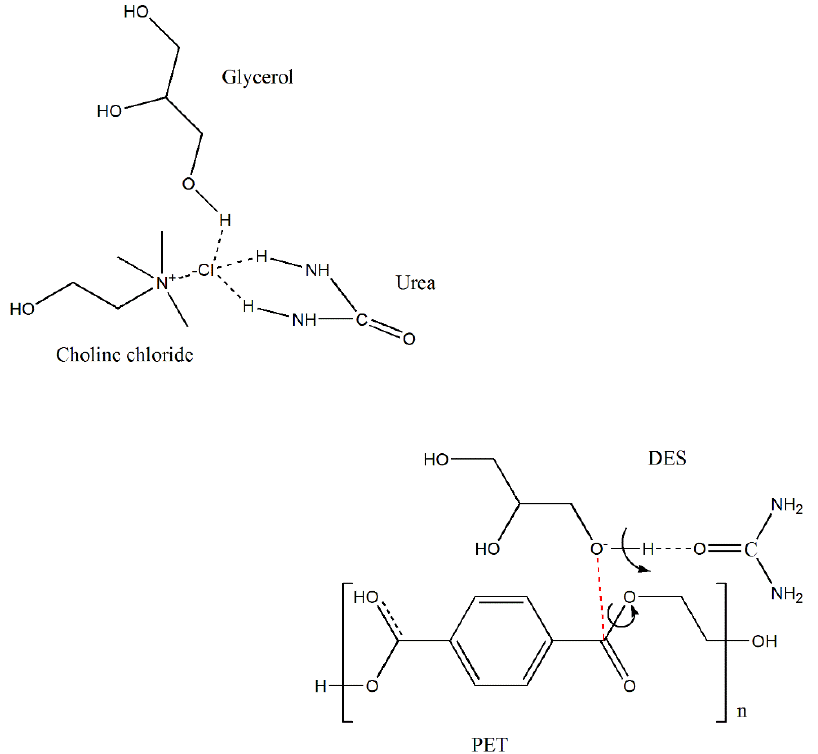
Figure 1. Schematic diagram for the proposed interactions of DES (composed of choline chlo- ride/urea/glycerol in the ratio of 1:1:1) with PET via hydrogen bonding.